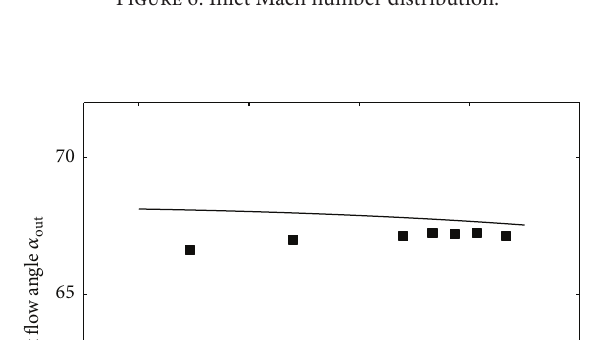
Figure 6: Inlet Mach number distribution.